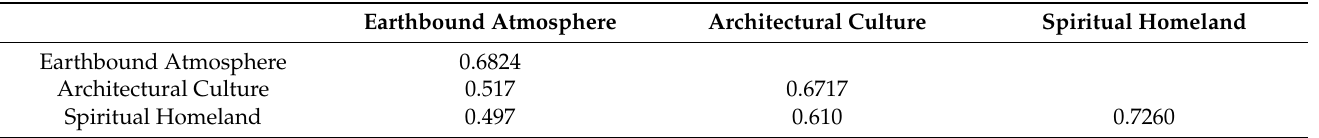
Table 6. Construct correlations and squared roots of AVE (Sample 2, n = 228).